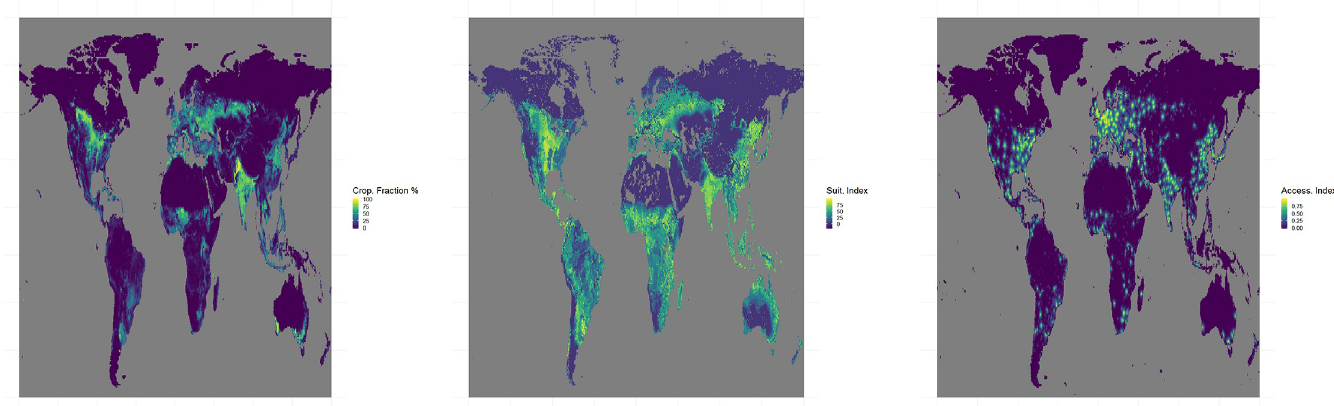
Fig 2. Cropland fraction in the year 2017 in percentage of grid cells from Goldewijk et et al. (Panel A). Index of agricultural suitability (min = 0, max = 100) from Zabel et al. (Panel B). Index of market accessibility (min = 0, max = 100) from Verburg et al. (Panel C). https://doi.org/10.1371/journal.pone.0242222.g002 remote areas. The largest proportion of unsuitable land (index = 0) is found in Middle East and North Africa (14%) and Eastern Europe (9%), and the largest proportion of inaccessible land (index = 0) is found in Oceania and South-Eastern Asia (23%) and Southern Africa (11%). Due to the relatively low resolution of the maps and the granularity of the indices (in terms of decimal place), the quartiles obtained do not exactly yield a homogeneous distribution of 25% land by quartiles. This is particularly the case for the suitability index, whose granularity